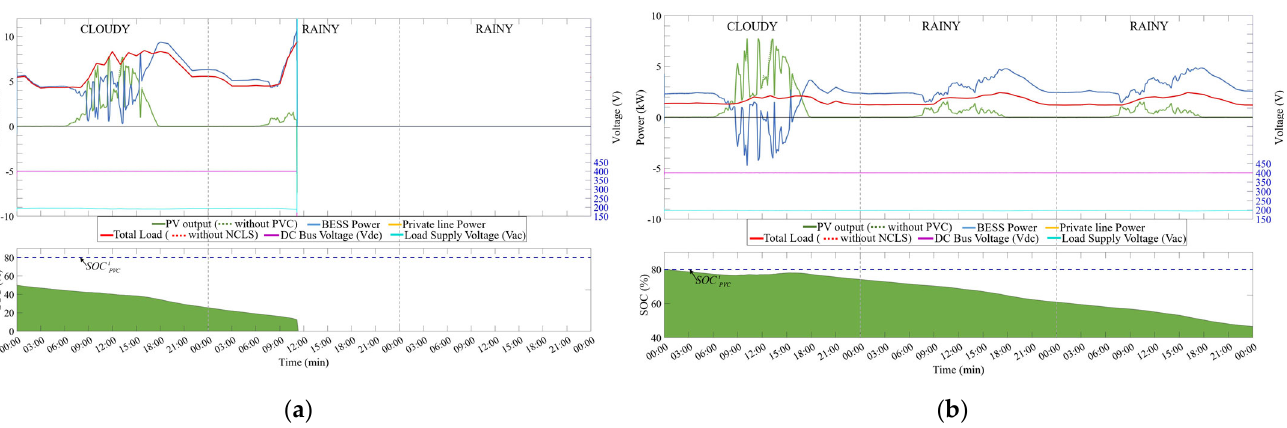
Table 2. Summary of Related Works: Control Parameters and Features.